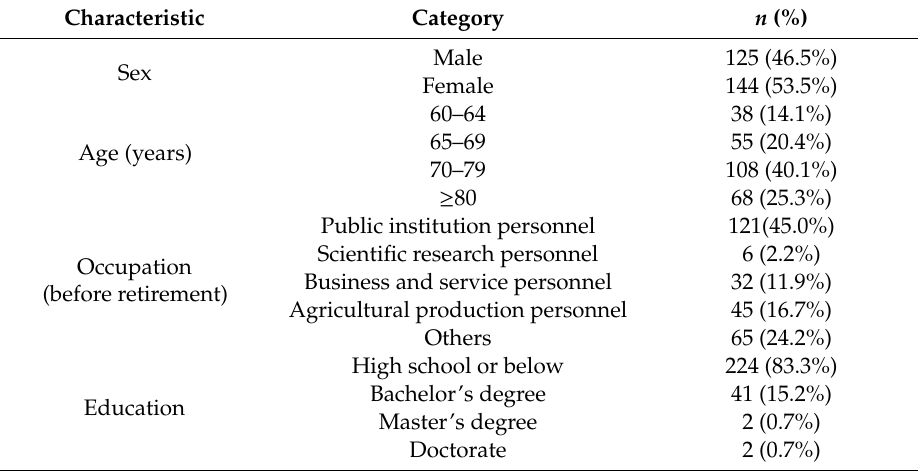
Table 1. Demographic characteristics of the participants (N =